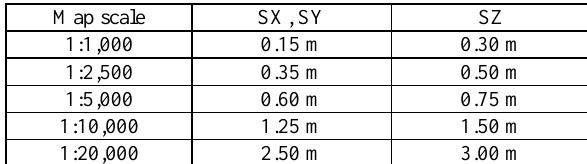
Table 1. The required horizontal standard deviations with 0.12